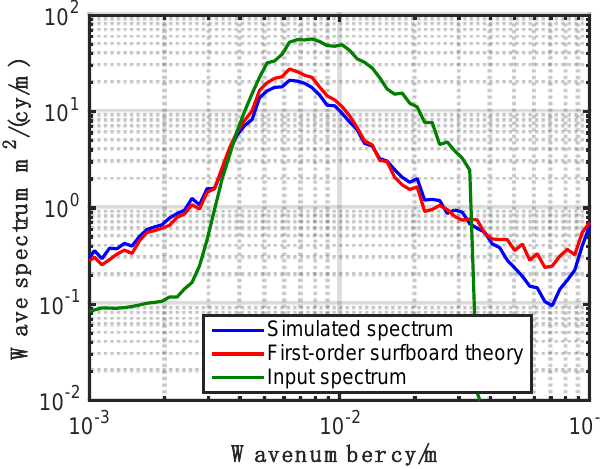
Figure 10. Comparison between the simulated spectrum for the radar retrieved height (blue) and the first order theory in the Appendix (red) given an input Pierson-Moskovitz ocean wave spectrum (SWH = 3 m) aligned in the cross-track direction (green), where ocean wavelengths smaller than 30 m have been removed for computational purposes. The spectra are computed using data for the ground range interval from 50 km to 60